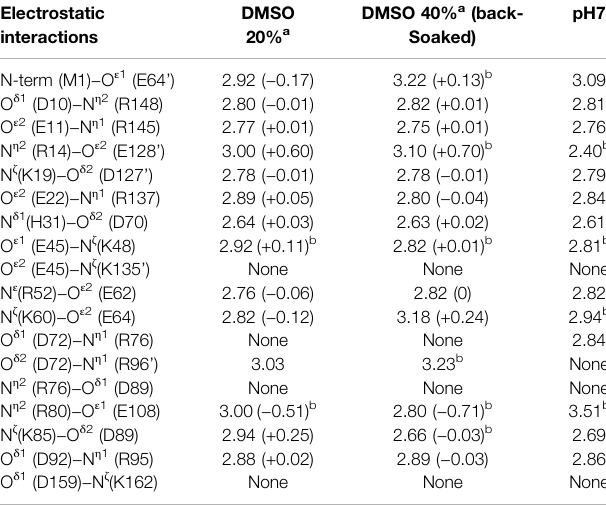
TABLE 3 | Comparison of the electrostatic interactions observed in the structures in the absence or presence of DMSO. Selected interactions within 3.6 Å are listed,wheretheircoordinateuncertaintieswereestimatedfromtheCruickshank ’ s DPI to be 0.06 Å for the structure soaked into a 20% ( v / v ) DMSO solution and 0.03 Å for that back-soaked into a DMSO-free solution,